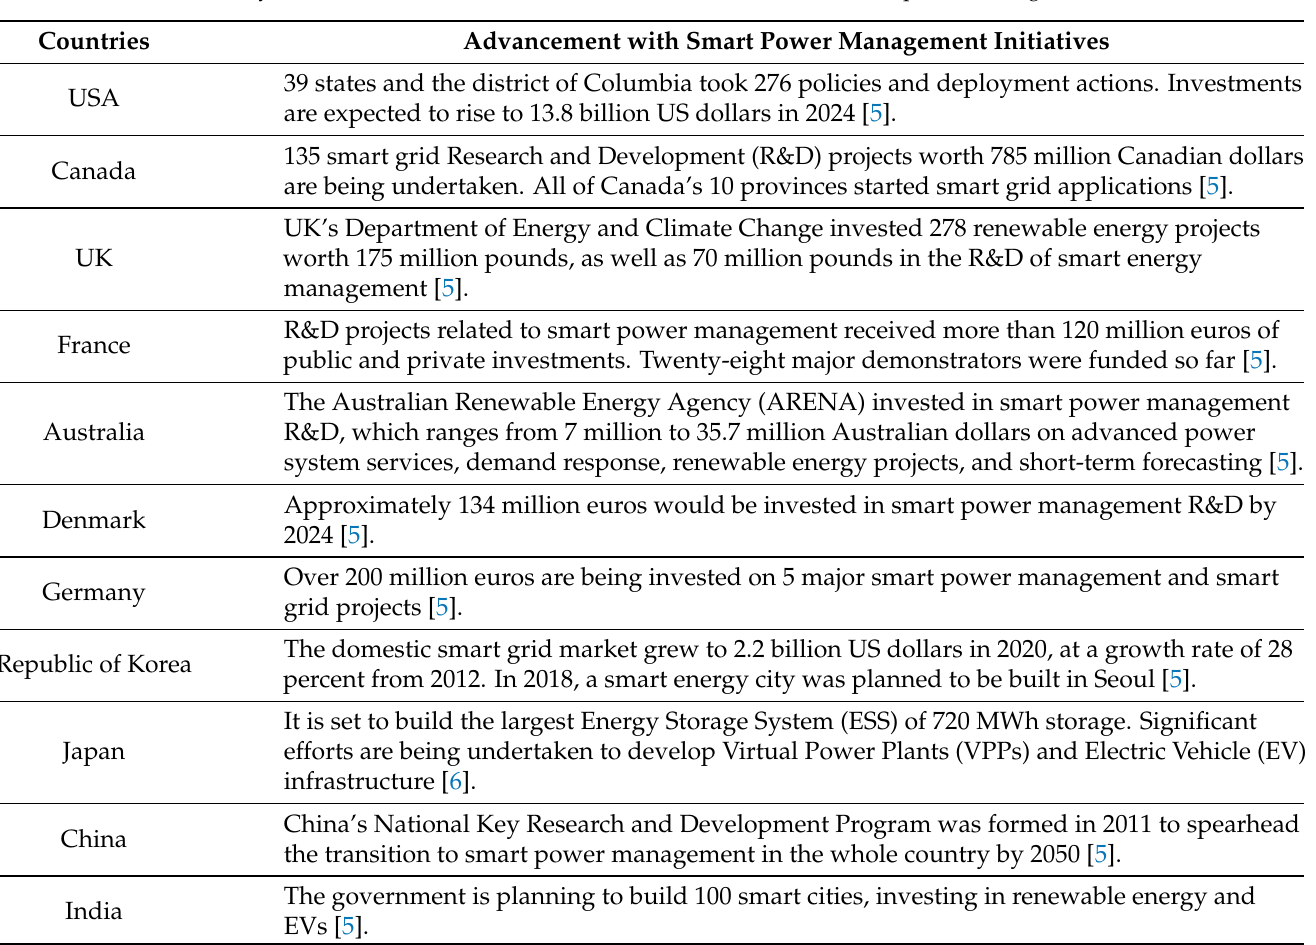
Table 1. Summary of advancements of the non-OIC member countries with smart power management initiatives.